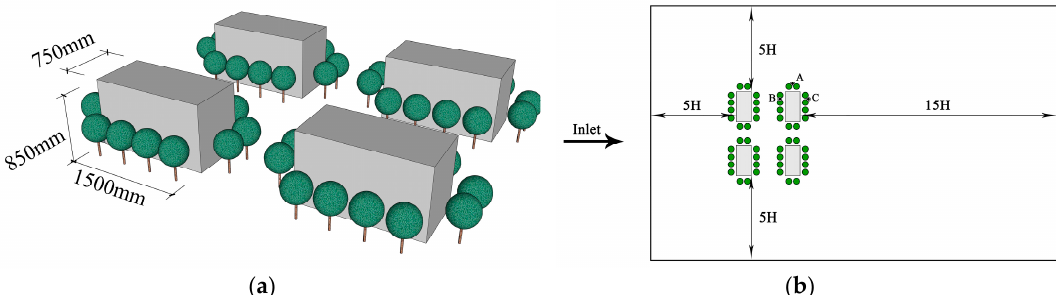
Figure 1. Setup for computational fluid dynamics (CFD) validation. ( a ) The building and tree models were replicated in the wind tunnel test; ( b ) Top view of the computational domain setting.